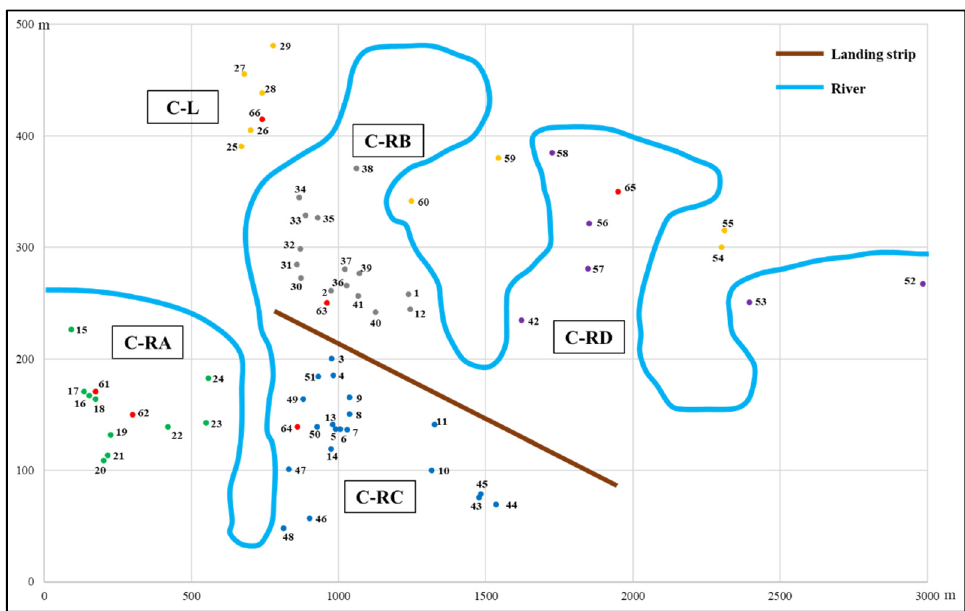
Figure 6. Demand and potential generation points in Conambo. Numbers refer to the households (blue) and potential generation points (red).